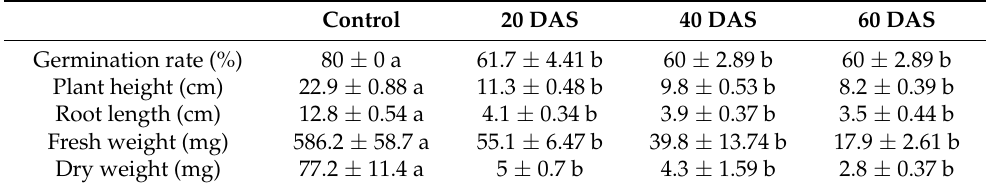
Figure 3. The effect of dominance of Solanum carolinense on the growth of Festuca arundinace . Table 2. Effect of Solanum carolinense dominance on the growth of Festuca arundinacea at different time intervals.